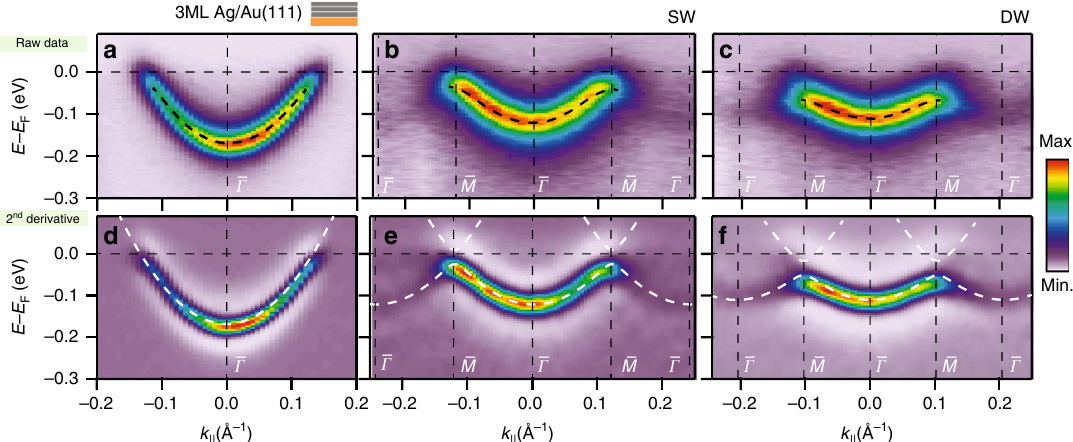
Fig. 3 2DEG modi fi cation induced by the SW and DW network potential barriers. a – c ARPES map along Γ M , obtained on the 3ML Ag/Au(111) as well as on the SW and DW networks. The energy distribution curves close to Γ were fi tted, using a Lorentzian component and a linear background convoluted with a Fermi function (black dashed lines). d – f Second derivative maps of the above raw data for an improved visualization of the second surface Brillouin Zone. The white dashed lines correspond to the EBEM calculated electronic bands stemming from altering the 2DEG with the molecular surface potentials.